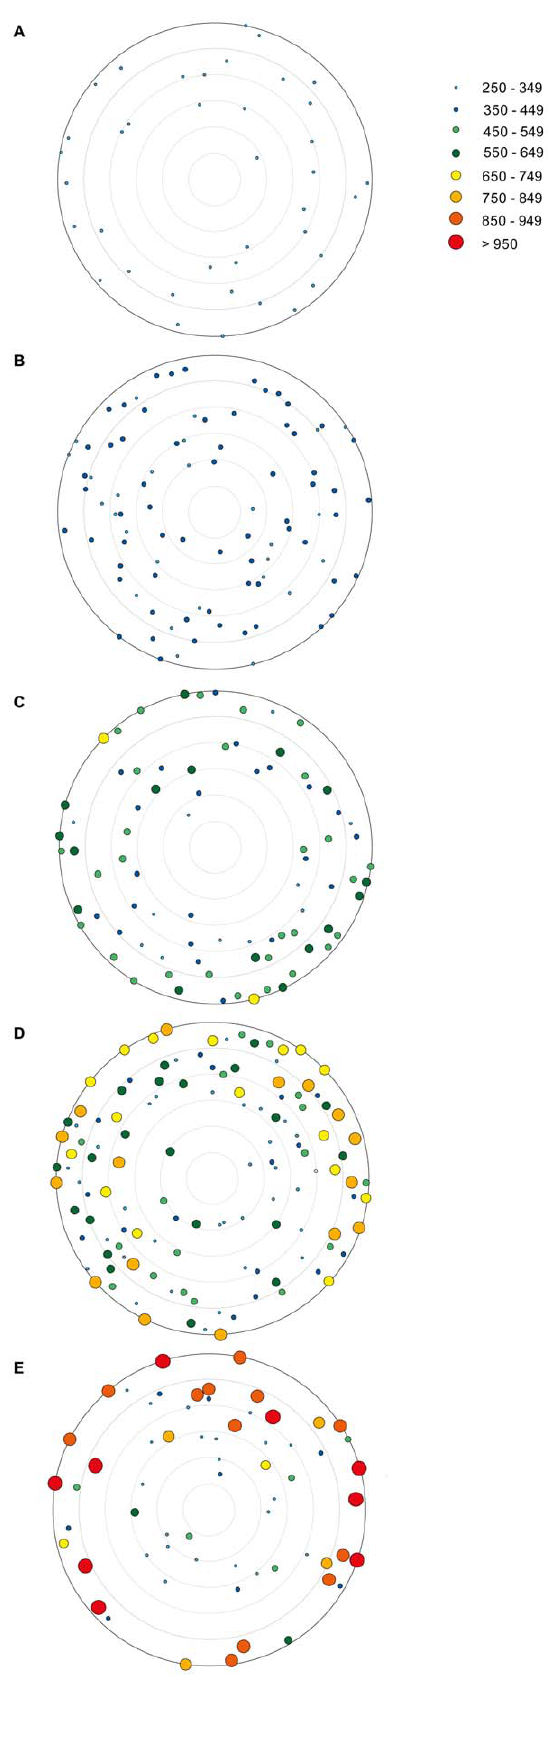
Figure 5. Schematic diagram to illustrate micro spatial scale settlement of individual mussels on and within ropes. (A) 1 day, (B) 5 days, (C) 9 days, (D) 13 days, and (E) 17 days post settlement. The size classes of mussels (250–349, 350–449, 450–549, 550–649, 650–749, 750–849, 850–949, and . 950 m m in shell length) are indicated by different colours. The depth of penetration was identified using X-ray m CT and each schematic summarises the overall settlement on all three analysed ropes, therefore representing an overall rope length of approximately 105